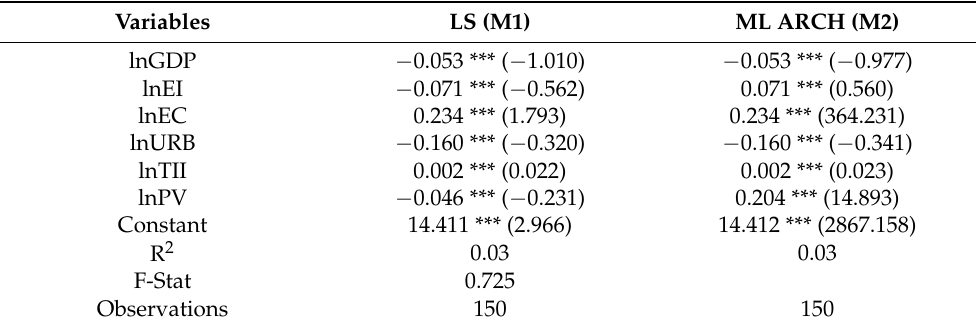
Table 11. Panel estimation results: Western Cape CO 2 - eq emissions in the transport